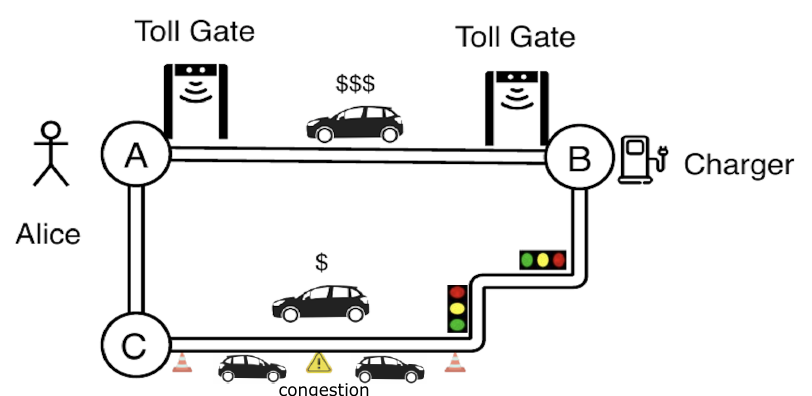
Figure 1. Self-driving M2X running case incorporating smart traffic lights and a traffic-congestion response, adapted from